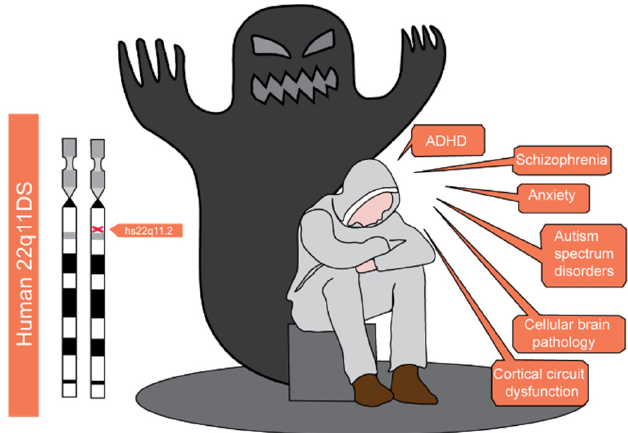
Figure 1. Phenotypic features of 22q11.2 Deletion Syndrome (22q11DS). The chromosomic location of the deletion (left) and the most common manifestations of the disease (right) are shown. Starting from childhood and early adolescence 22q11.2 subjects face a wide range of neuropsychiatric illnesses which include attention deficit disorder (ADHD), schizophrenia spectrum disorder, anxiety, and autism spectrum disorders. A baseline cellular brain pathology and the consequent cortical circuit dysfunction are at the root of these alterations.